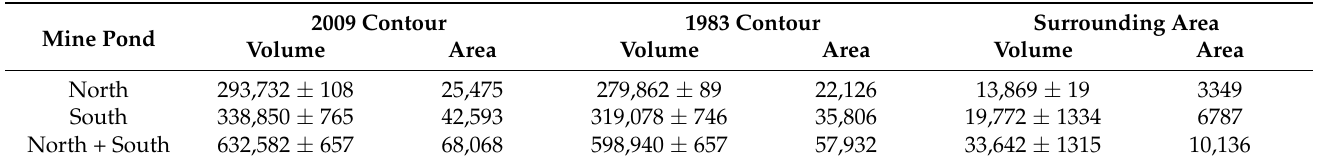
Table 2. Volume (m 3 ) and area (m 2 ) of sludge in 2009 (2009 contour), breaking down the values inside (1983 contour) and outside (surrounding area) the 1983 boundary of the ponds.